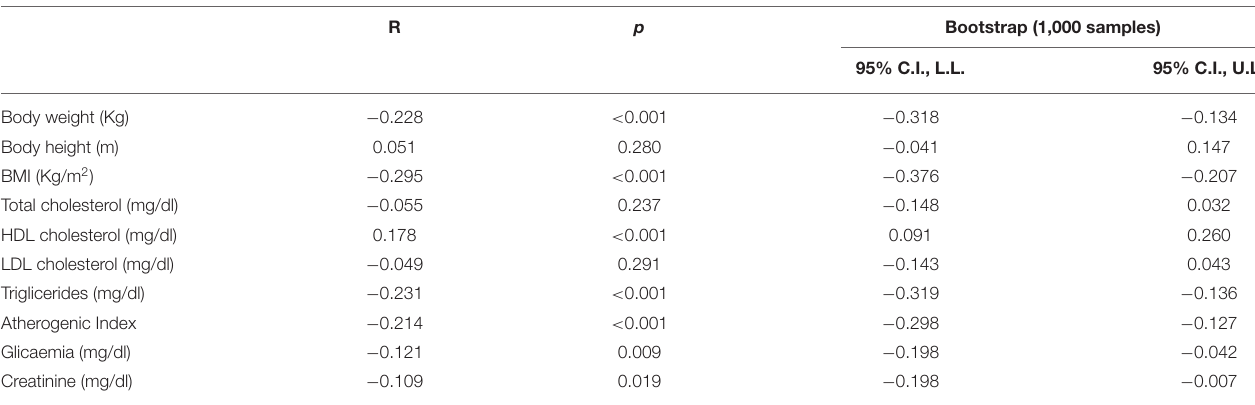
TABLE 2 | Partial correlations between CPARs and cardiovascular risk factors. R p Bootstrap (1,000 samples) 95% C.I., L.L. 95% C.I.,